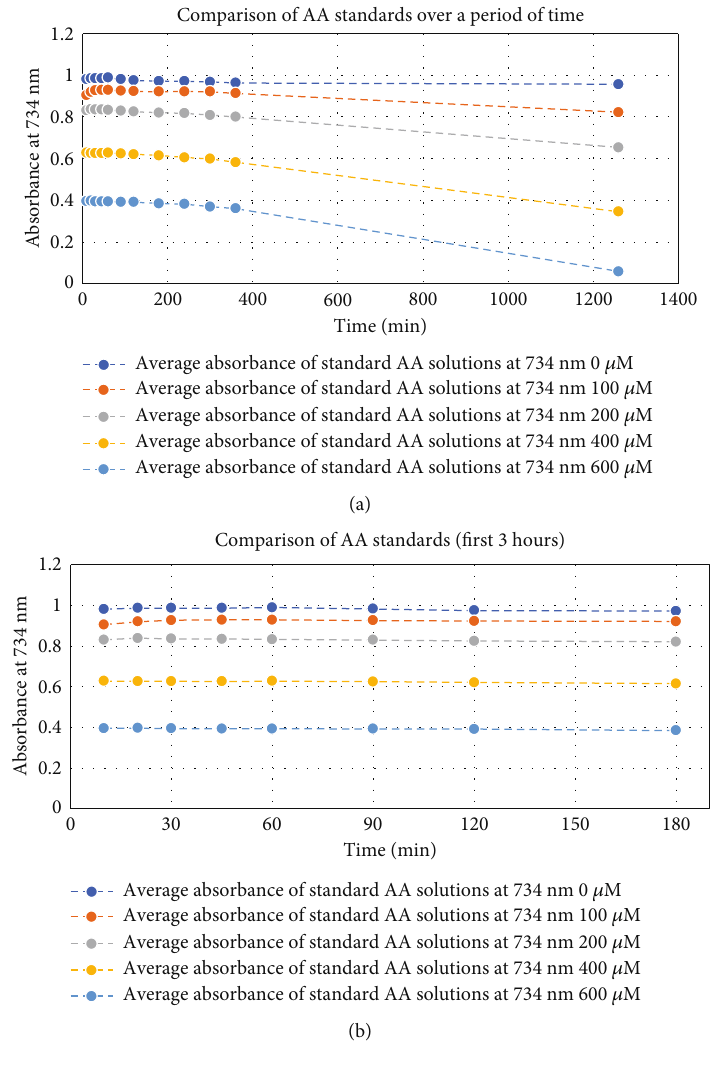
Figure 1: (a) Stability of AA working standards over time. (b) Stability of AA working standards for the fi rst 3